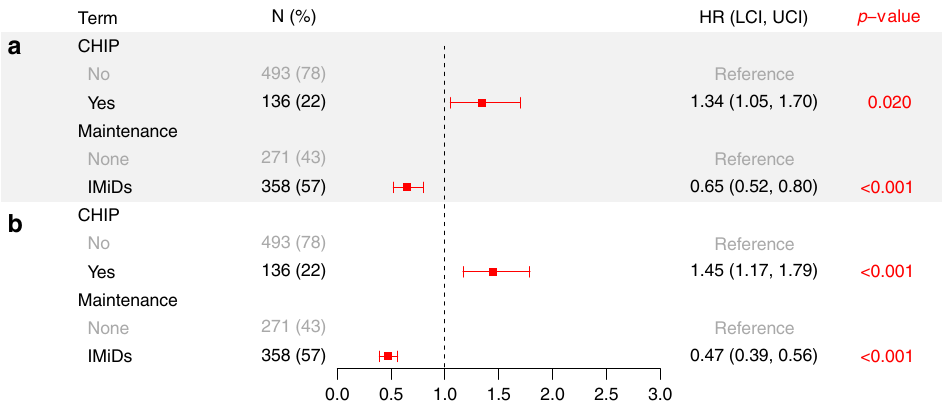
Fig. 3 Multivariable cox regression model of OS and PFS. a OS and b PFS models for all 629 patients after stratifying by age, ISS and number of lines of therapy prior to ASCT to investigate the effect of CHIP and IMiD maintenance on outcome. Two-sided Wald p-values are shown for each model coef fi cient with signi fi cant effects displayed in red. Exact p -values: A: 0.0197276361 and 0.0000692041; B: 0.0007310355 and 1.547737 × 10 − 15 . HR: Hazard Ratio; LCI: Lower Con fi dence Interval; UCI: Upper Con fi dence